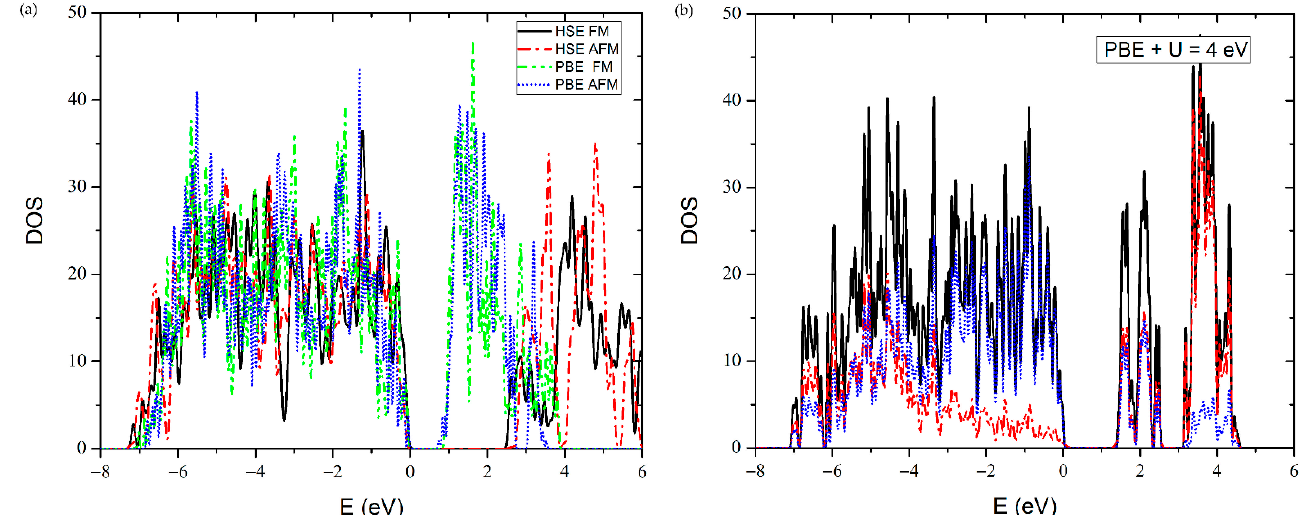
Figure 6. ( a ) The total density of states for ferromagnetic (FM) and antiferromagnetic (AFM) cases with HSE, and PBE.. The zero-energy is set to the valence band maximum. ( b ) PBE + U DOS with projections for Mn d (red) and O p (blue) states (AFM).